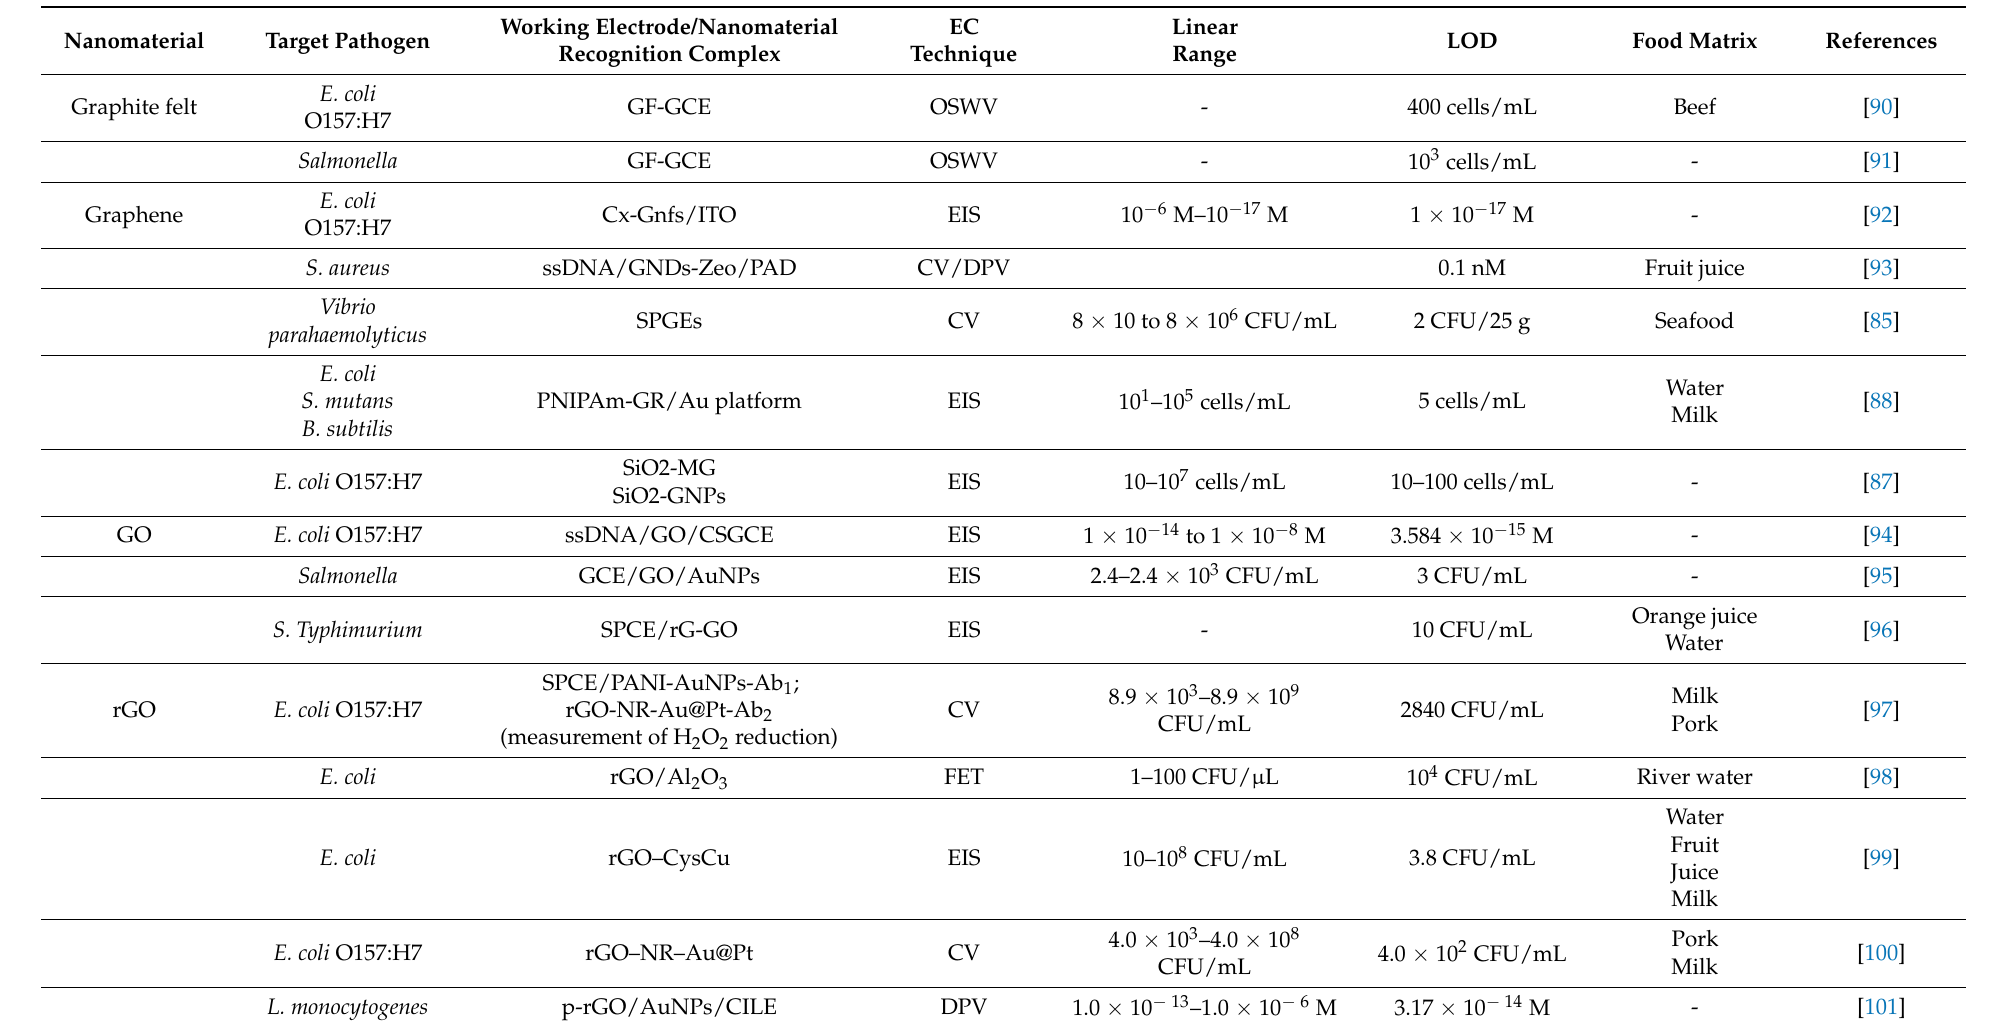
Table 1. Detection of pathogens in food with carbon-based integrated electrochemical